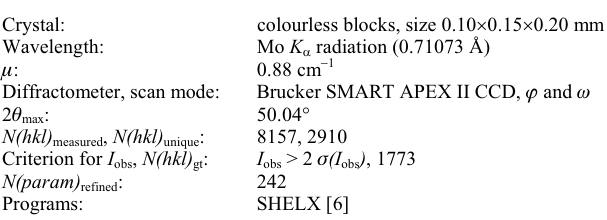
Table 1. Data collection and handling.